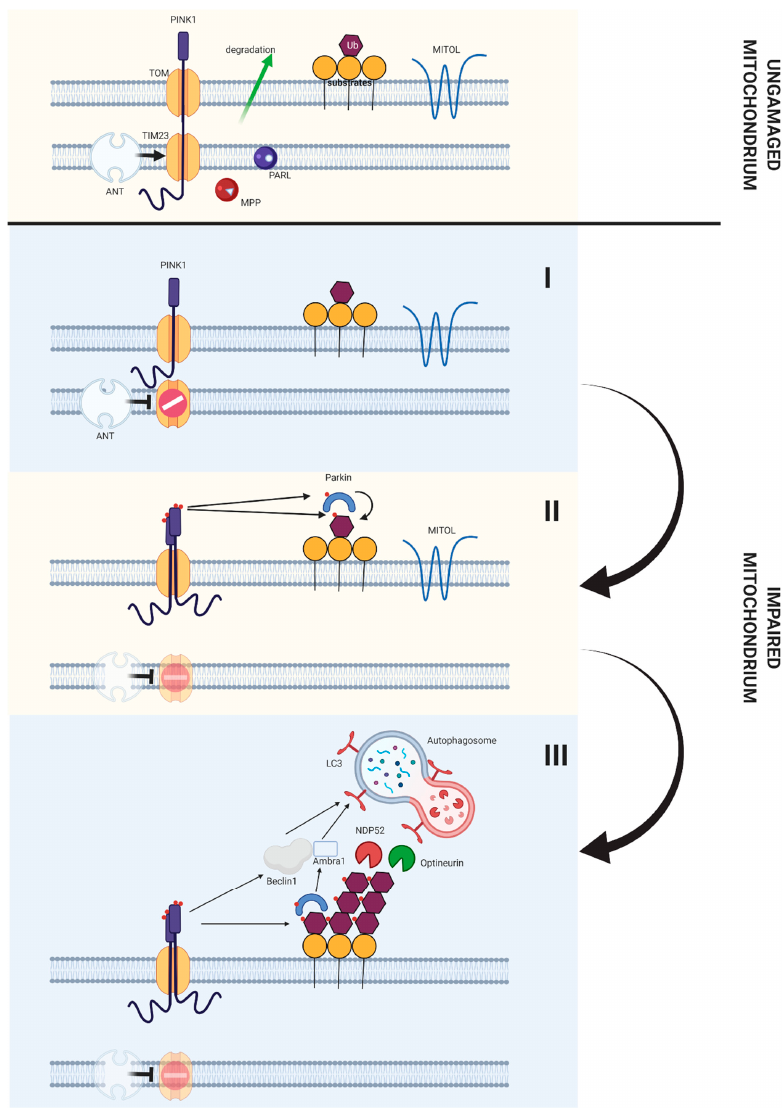
Figure 6. Role of the PINK1/Parkin pathway in induction of autophagy both in stem cells and differentiated cells. In a properly functioning mitochondria PINK1 is transported through the TOM/TIM23 translocase complex to the internal mitochondrial membrane. It is then disintegrated (due to the activity of two proteases, PARL and MPP), transported to cytosol and degraded. When mitochondria do not functioning properly (which manifests itself as a dysfunction of mitochondrial membrane potential), ANT inhibits the transport of PINK1 through the TIM23 translocase. As a result of this phenomenon PINK1 accumulates on the external mitochondrial membrane. Accumulation of PINK1 on the external mitochondrial membrane results in formation of complex consisting of PINK1 and TOM translocase, which results in autophosphorylation of PINK1 and its activation. The activated PINK1 phosphorises the ubiquitinated substrates located on the external mitochondrial membrane, which makes it possible to connect Parkin and its phosphorylation. Phosphorylated Parkin, in turn, contributes to the ubiquitination of subsequent proteins on the external mitochondrial membrane. The ubiquitinated proteins, in the other hand, are able to phosphorylate subsequent PINK1 molecules, thus creating a feedback loop, so that a malfunctioning mitochondrion is covered with phosphoubiquitin. Then mitophagic adapters Optineurin and NDP52 bind phosphoubiquitin chains. These proteins further bind the LC3 protein, which allows the initiation of mitophagy. At the same time PINK1 interacts with Beclin-1, Parkin and Ambra proteins, which contributes to the formation of autofagosome around the damaged mitochondria